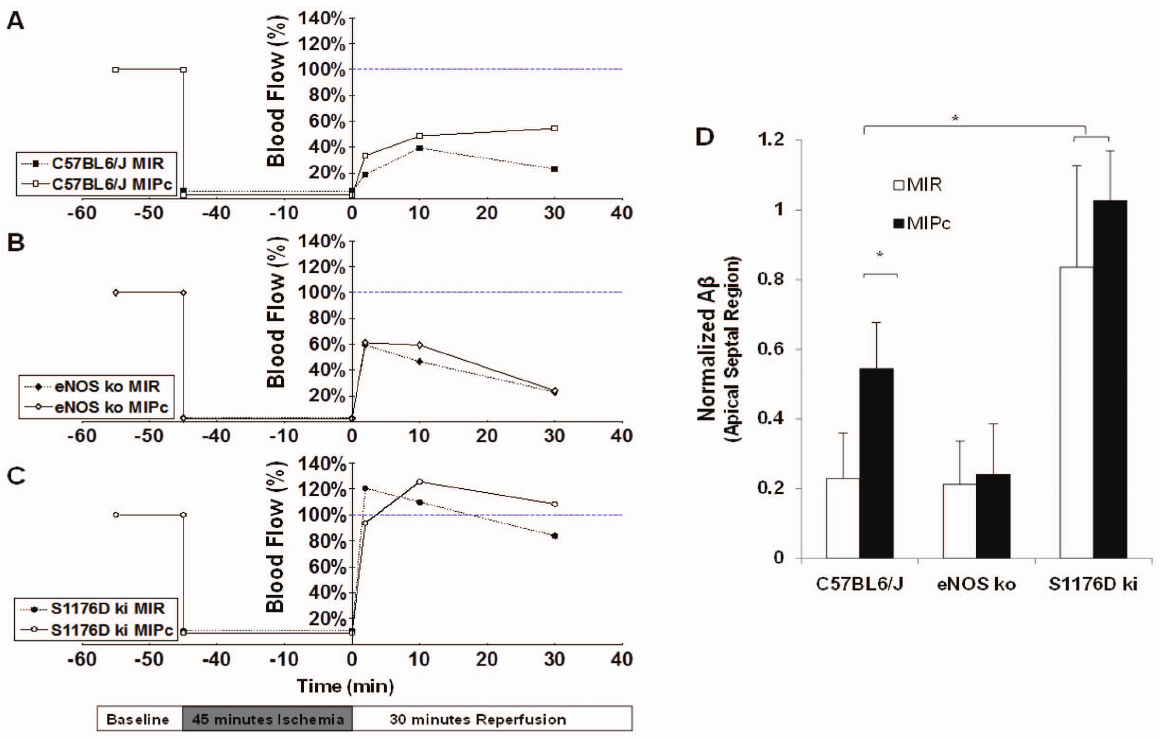
Figure 4. Temporal myocardial contrast echocardiography. Myocardial blood flow (A b ) profiles in the apical region for A. C57BL/6J mice. B. eNOS knockout mice, and C. S1176D knockin mice. Levels of myocardial myocardial blood flow were normalized to baseline values and measured at 2, 10 and 30 minutes after reperfusion. D. Apical myocardial blood flow 30 minutes after reperfusion. MIR: Traditional myocardial ischemia with reperfusion, MIPc: Myocardial ischemia with postconditioning. n=5–6 per group. Data are expressed as the mean 6 SD. *P , 0.05.